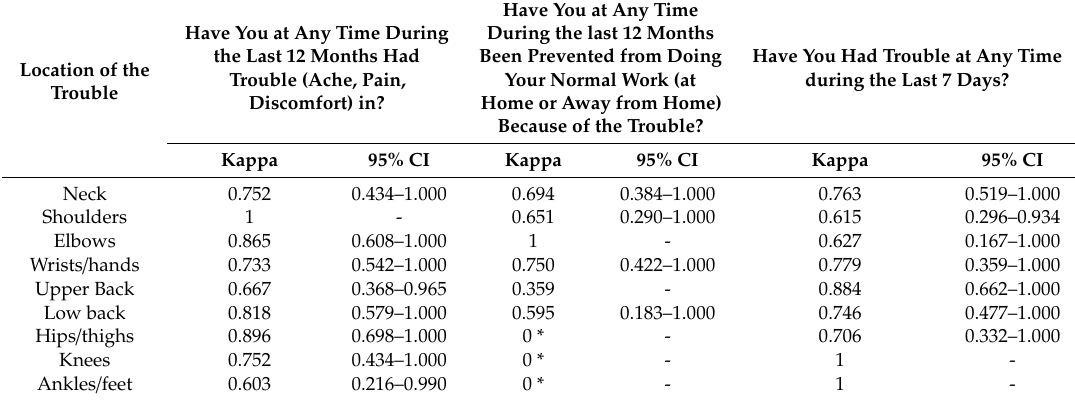
Table 1. The Kappa agreement correlation coefficient for each answer in the general questionnaire ( n = 25).